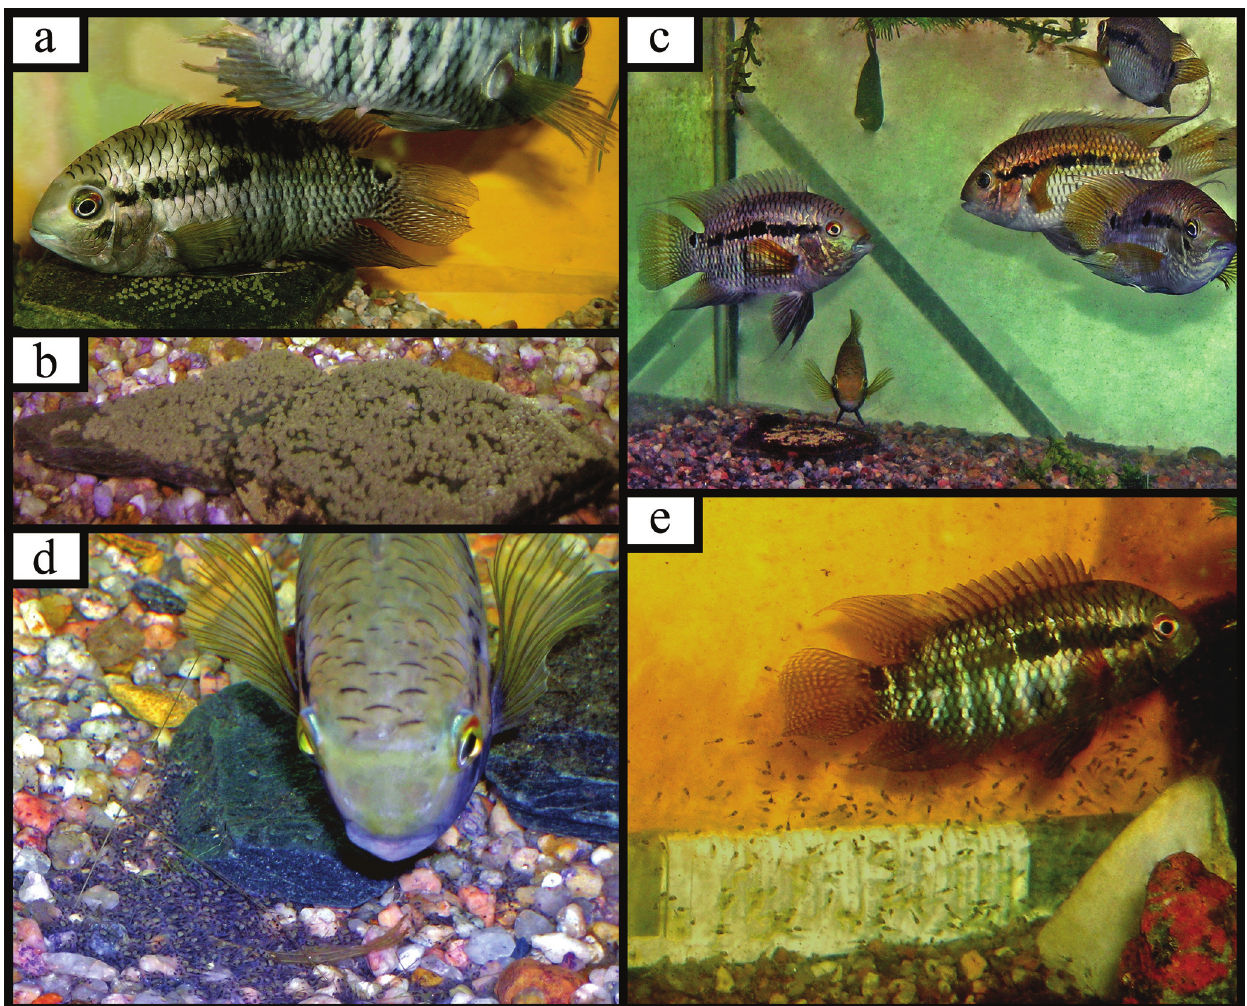
Fig. 4. Reproductive phases: a ) Female laying eggs while male waits to fertilize them. This process is then repeated; b ) Spawn on a flat dark stone. Generally between 400 - 800 eggs are laid, depending on female size; c ) Female guarding the eggs while male attacks an intruder male. Generally one of the parents remains guarding the fry while the other feeds or defends the territory; d ) Female fanning non swimming fry after transferring them to a previously dug pit; fry hatched 3 days after fertilization; e ) Male guarding free swimming fry (8 days after fertilization); parents seem to attract the fry by shaking its dark pelvic